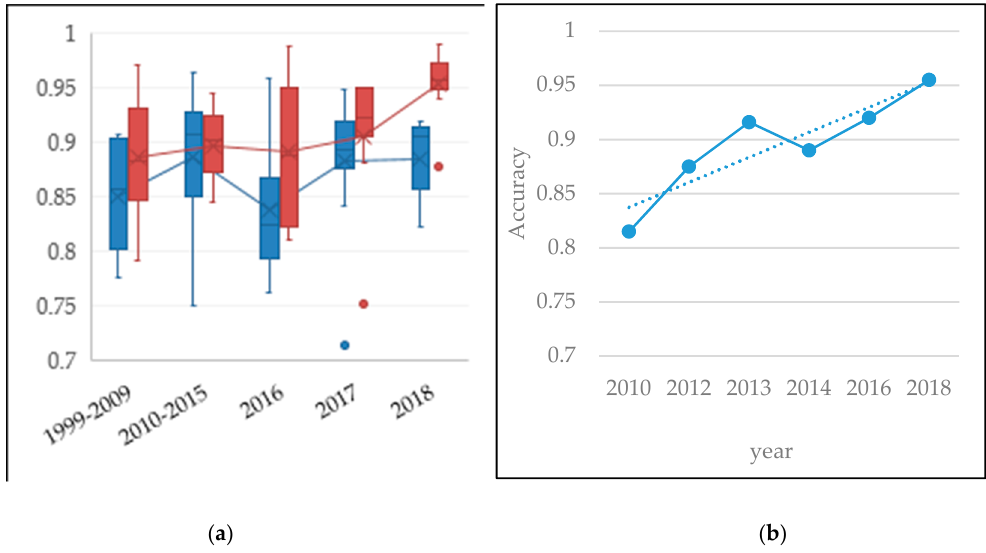
Figure 8. Trend of performance for selected papers: ( a ) the performance of two-type classification. The blue and red boxes indicate the accuracy and AUC, respectively. Each box indicates the worst, best, and median performance. ( b ) The performance of four-type classification.